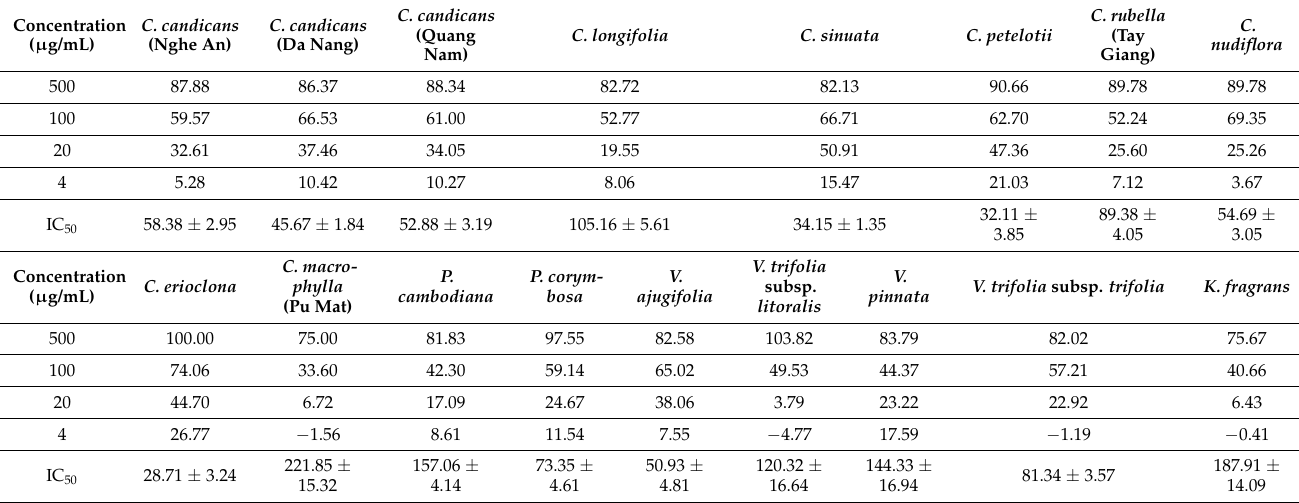
Table 2. Acetylcholinesterase inhibitory activity of essential oils of Callicarpa, Premna , Vitex and Karomia species from Vietnam.